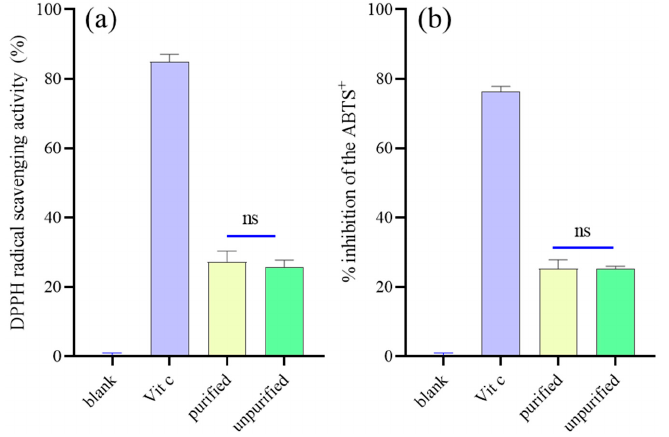
Figure 1. ( a ) DPPH and ( b ) ABTS radical scavenging activity of DCM-PLS purified and unpurified by activated carbon. ns: not significant ( p > 0.05).